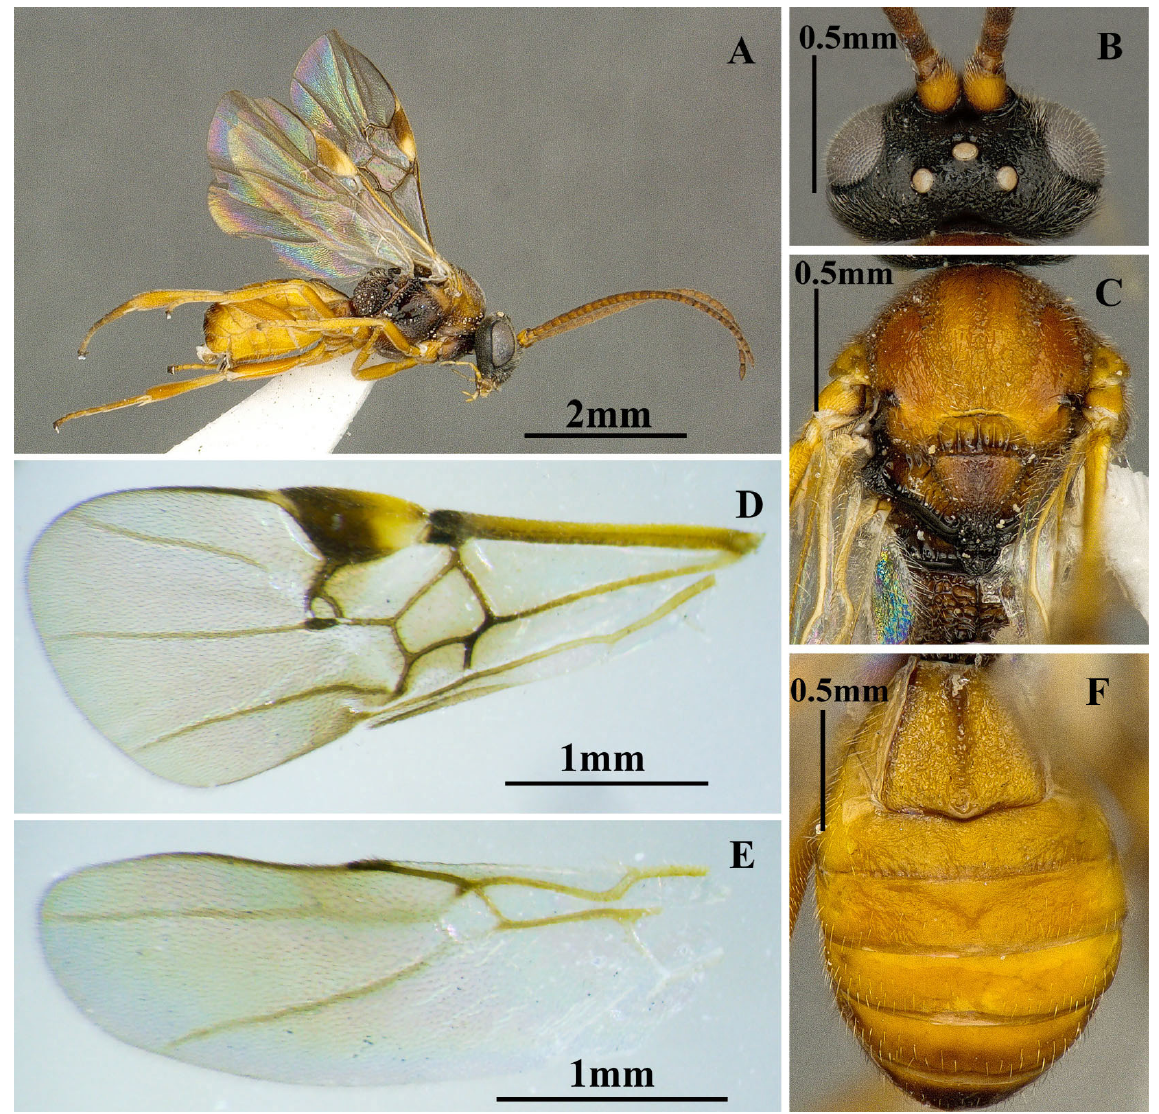
Fig. 8. Microplitis ochraceus Szepligeti, 1896, ♀, TMUC-HBMMP0055. A . Habitus, lateral view. B . Head, dorsal view. C . Mesosoma, dorsal view. D . Fore wing. E . Hind wing. F . Metasoma, dorsal